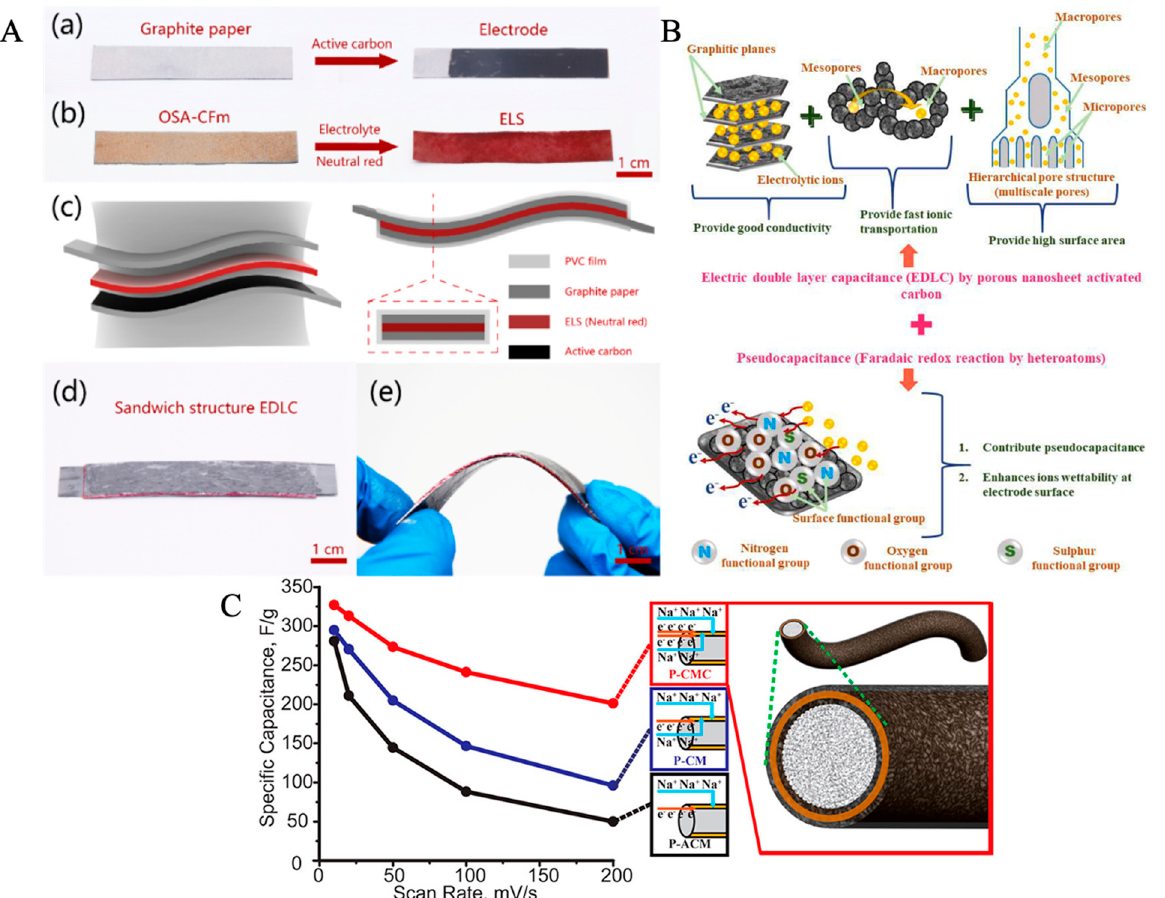
Figure 7. Various biopolymers utilized for fabrication of capacitors. ( A ) Synthesis of novel locked collagen separator with unique ( a – d ) sandwich structure, composed of electrolyte and electrode, and ( e ) bending ability as material for supercapacitors to better interface electrolyte and porous scaffold [100]. ( B ) Utilization of keratin from human hair for electrodes of capacitor in order to enhance specific capacitance [67]. ( C ) Application of hydrophilic cellulose properties in a film (paper/CNTs/MnO 2 /CNTs (P-CMC), paper/CNTs/MnO 2 (P-CM), or paper/Al 2 O 3 /CNTs/MnO 2 (P-ACM)) to guide electron movement in electrolyte [141]. Reproduced with permissions (( A ).